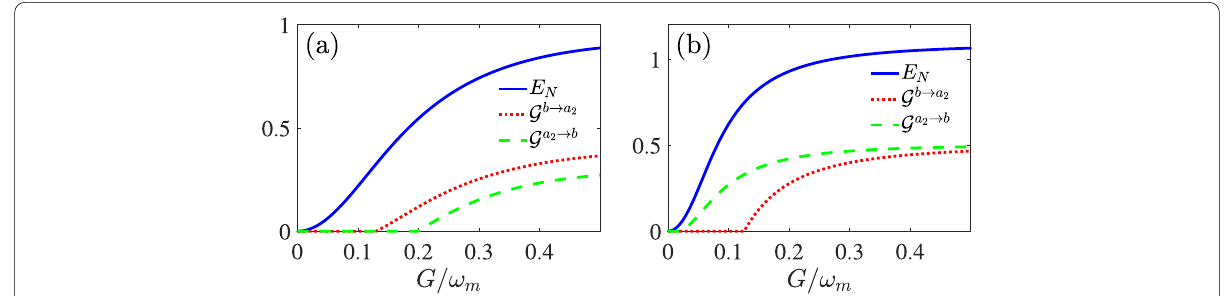
Fig. 7 The steady‑state optomechanical entanglement E N and Gaussian steering G b → a 2 and G a 2 → b versus the optomechanical coupling strength G G 2 / (cid:31) , and the other parameters are same as Fig. 0.1 ω m and b κ 2 0.001 ω m . We set (cid:31) 0.5 G , J for a κ 2 = = = =